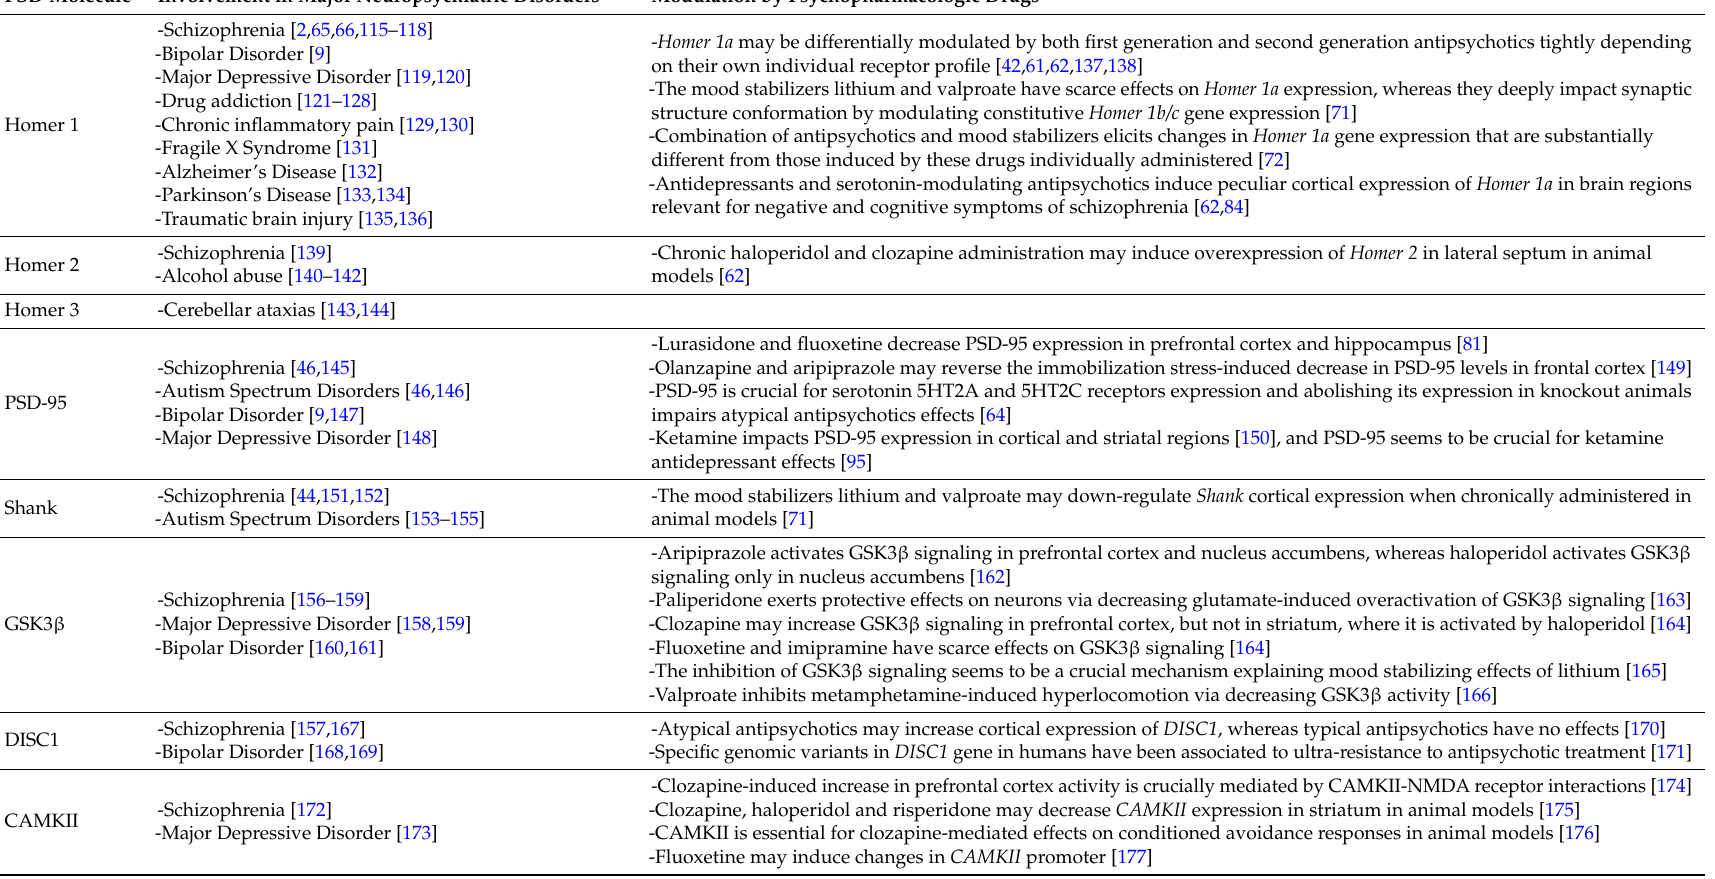
Table 1. PSD molecules involvement in major neuropsychiatric disorders and their modulation by main psychopharmacologic treatments. PSD